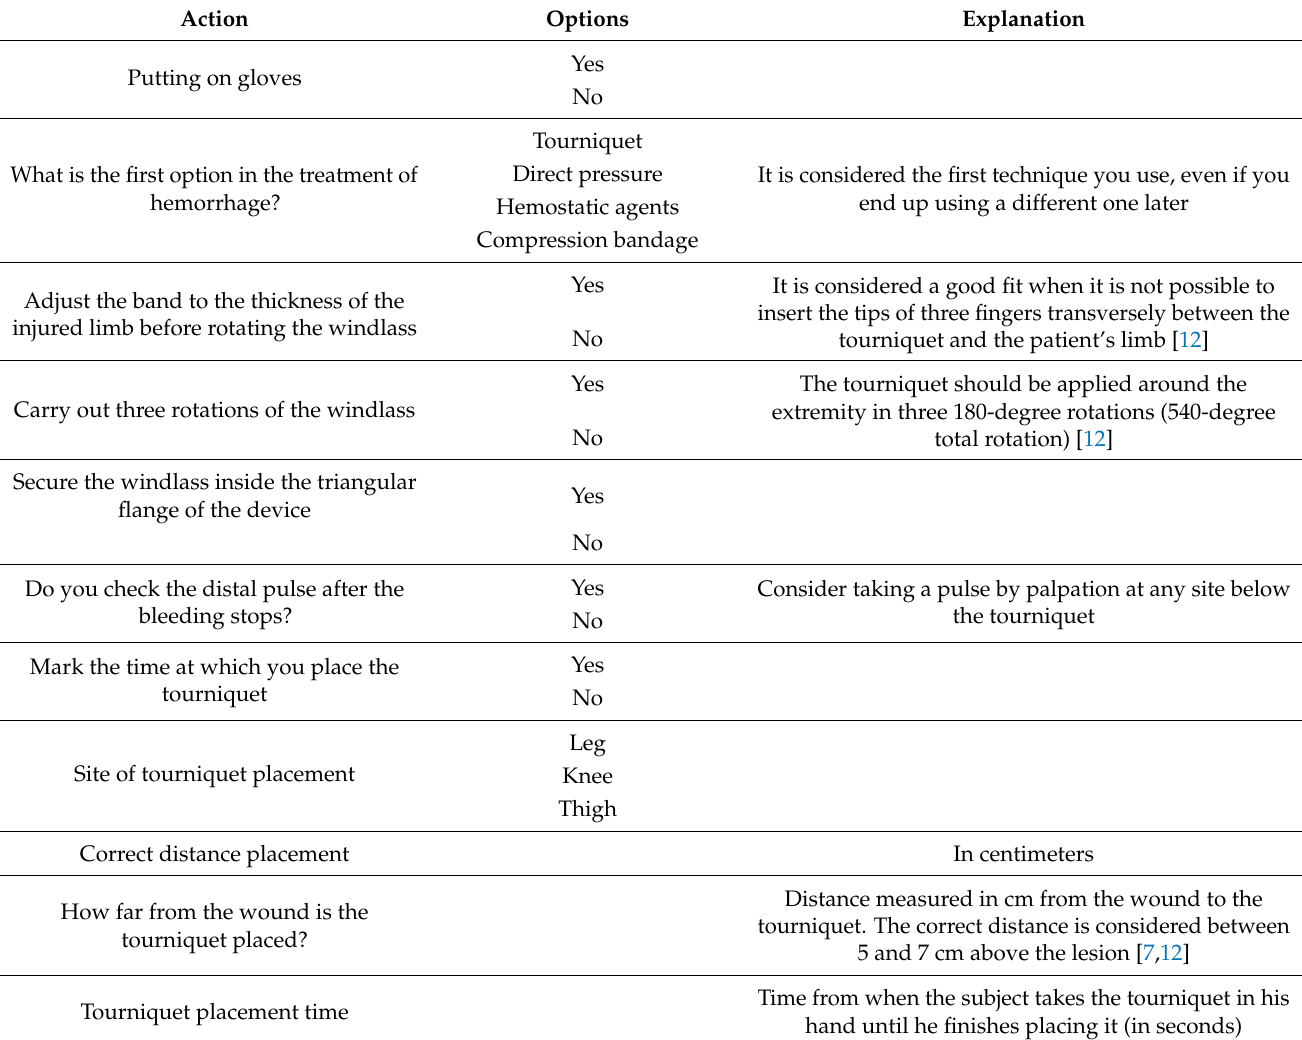
Table 1. Skill variables in hemorrhage